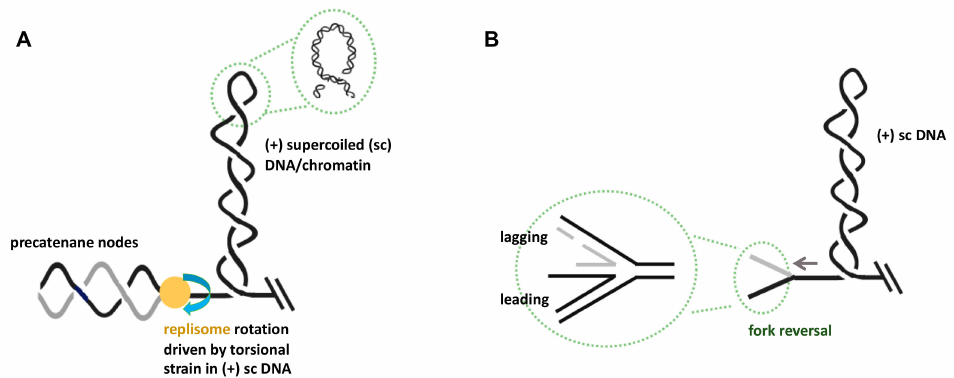
Figure 1. Consequences of excessive topological strain in the unreplicated DNA at stalled replication forks. ( A ) Topological strain in the form of left-handed interwound (plectonemic) duplex windings in the parental DNA (i.e., ( + ) supercoiling) can be transformed into right-handed braided precatenane structures behind the replisome. This transformation process will require the free rotation of replisomes or their disassembly. ( B ) Fork reversal as a consequence of topological strain ahead of the replication fork can lead to four-way DNA structures at the branch point. Note that for simplicity, chromatinization of DNA has been omitted in the drawings, and that duplex DNA is depicted as a single line. See text for detailed descriptions of these